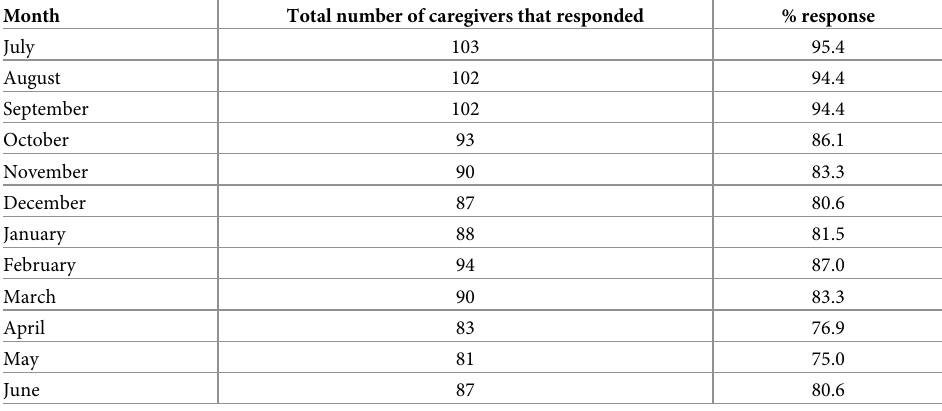
Table 3. Proportion of caregivers who reported on their children’s developmental milestones (N = 108).